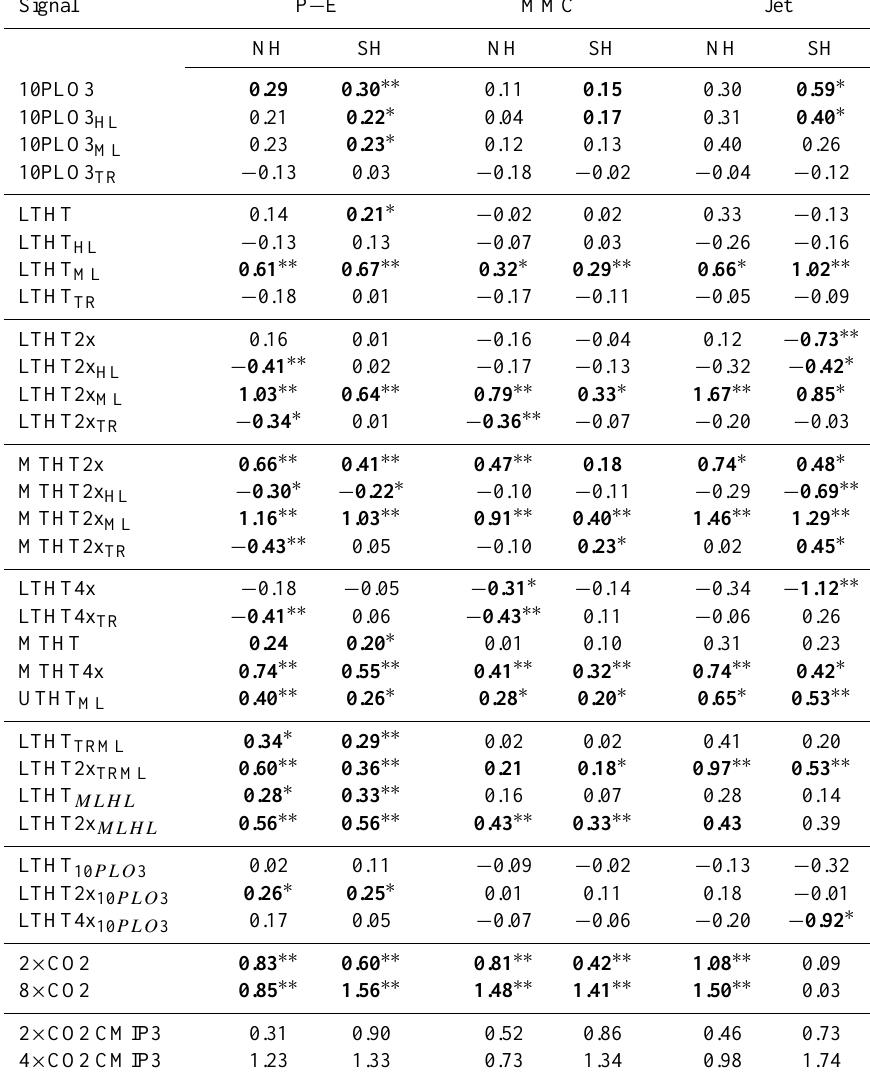
Table 5. Annual mean poleward displacement (degrees latitude) of several measures of tropical width for the (top) stratospheric cooling experiments and (middle and bottom) tropospheric heating/global warming experiments, including the CMIP3 2 × CO2 and 4 × CO2 ensemble mean. These measures are based on the subtropical dry zone (precipitation minus evaporation, P − E ), mean meridional mass circulation (MMC) and the tropospheric (850–300hPa) jet. See text for further description. Significance is denoted as in Table